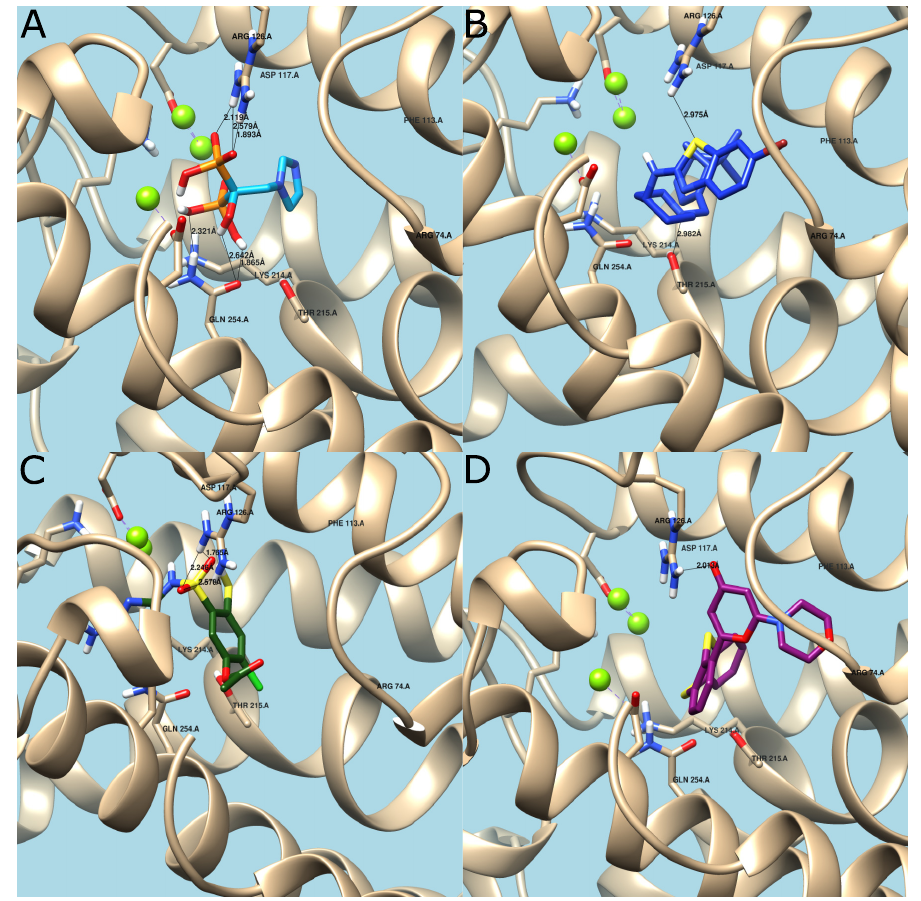
Fig 9. Molecular docking. (A) Zoledronate’s interaction with active site. Hydrogen bonds with Arg126 and Gln254. Binding Energy = -5.92. (B) CHEMBL250434’s interaction with active site. Hydrogen bonds with Arg126 and Thr215. Binding Energy = -10.04. (C) CHEMBL2007613’s interaction with active site. Hydrogen bonds with Arg126. Binding Energy = -9.56. (D) CHEMBL222102’s interaction with active site. Hydrogen bonds with Arg126. Binding Energy =